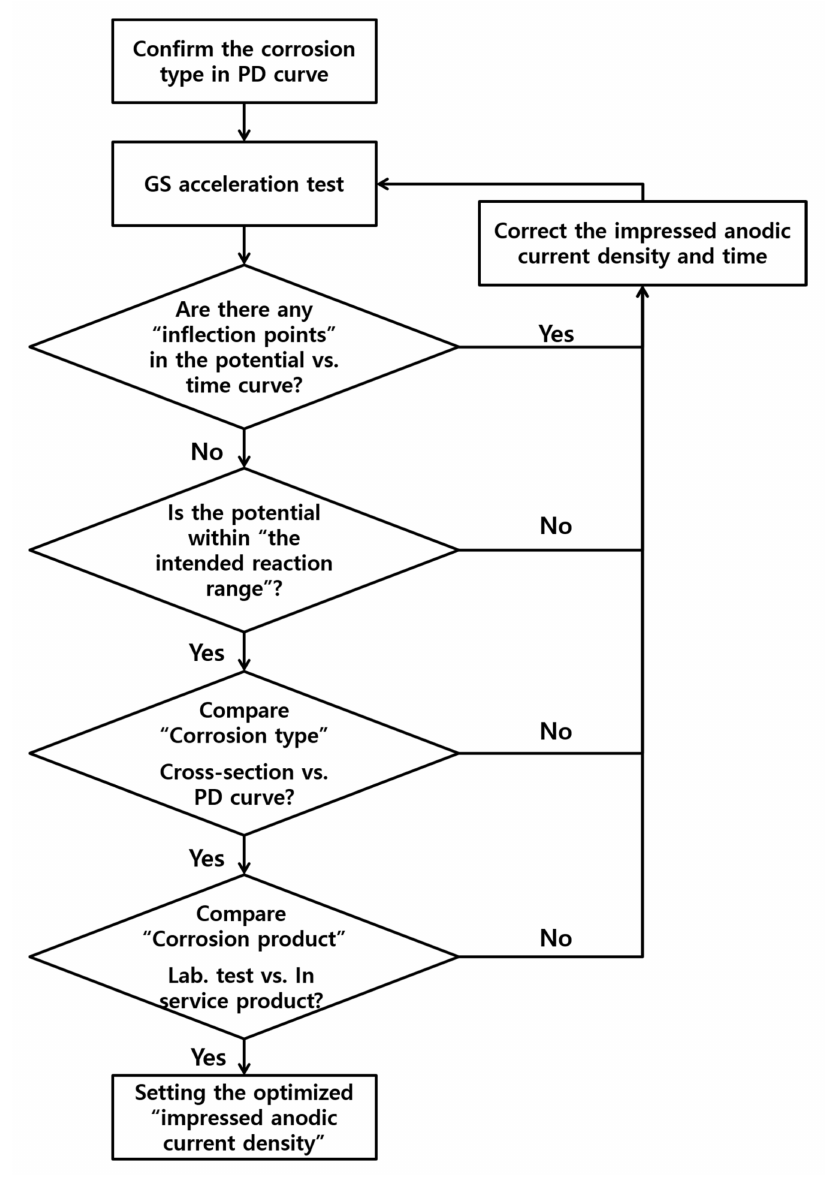
Figure 6. Flowchart showing the validation process for the GS accelerated